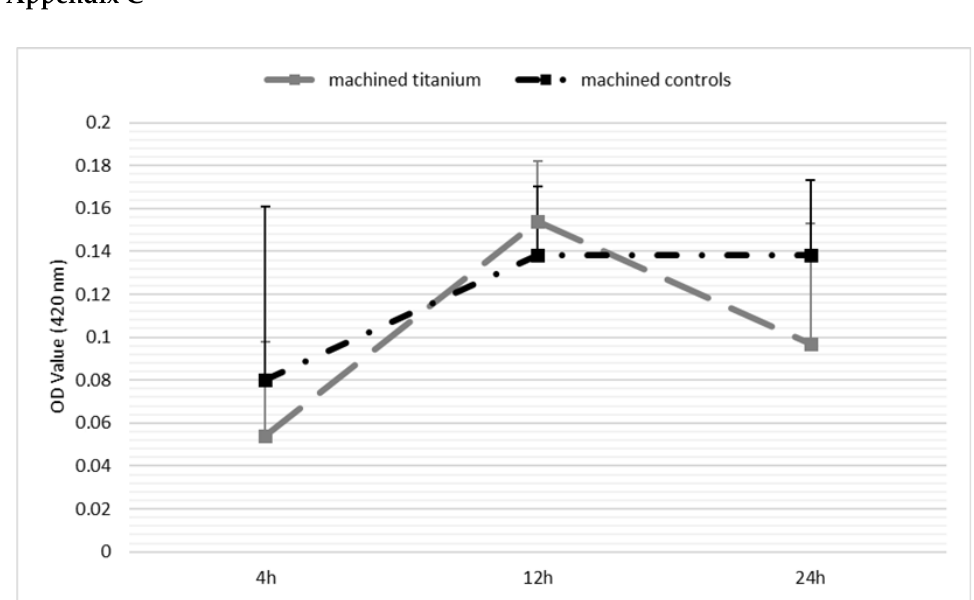
Figure A3. Comparison of cell proliferation using the WST-1 assay after 4, 12, 24 h between machined titanium samples and controls. The squares correspond to the mean value, the line on top to the ± standard deviation.